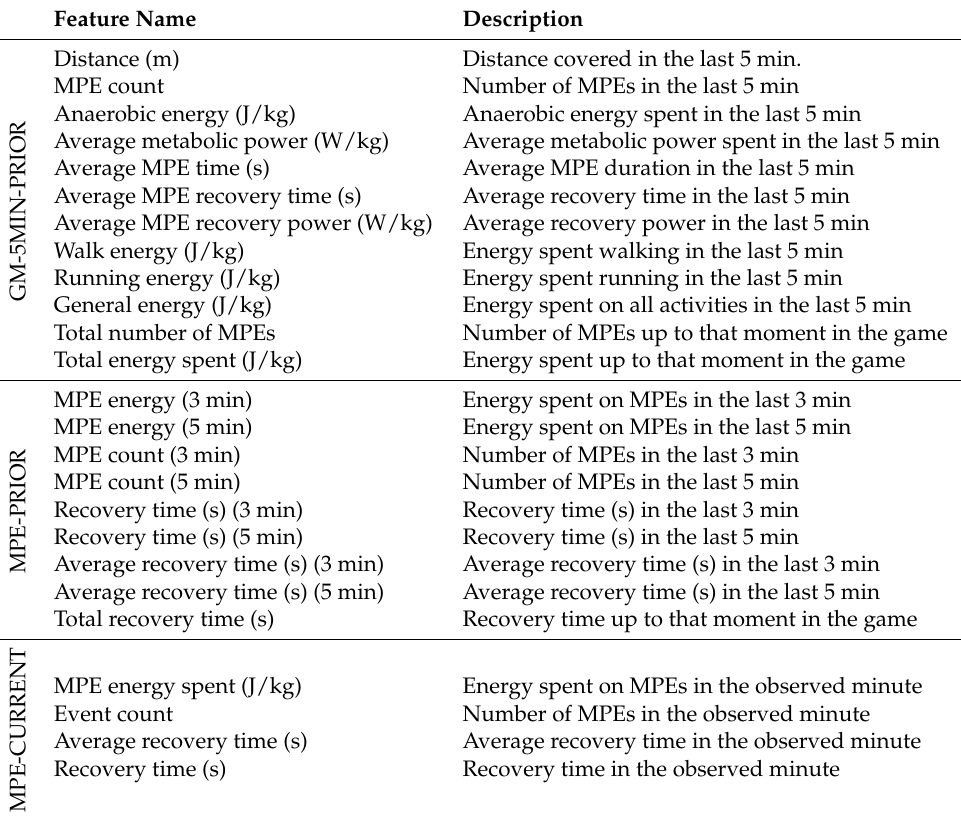
Table 1. A list and description of features used for clustering. Features are divided into 3 categories depending on the data source: GM-5MIN-PRIOR, MPE-PRIOR, and